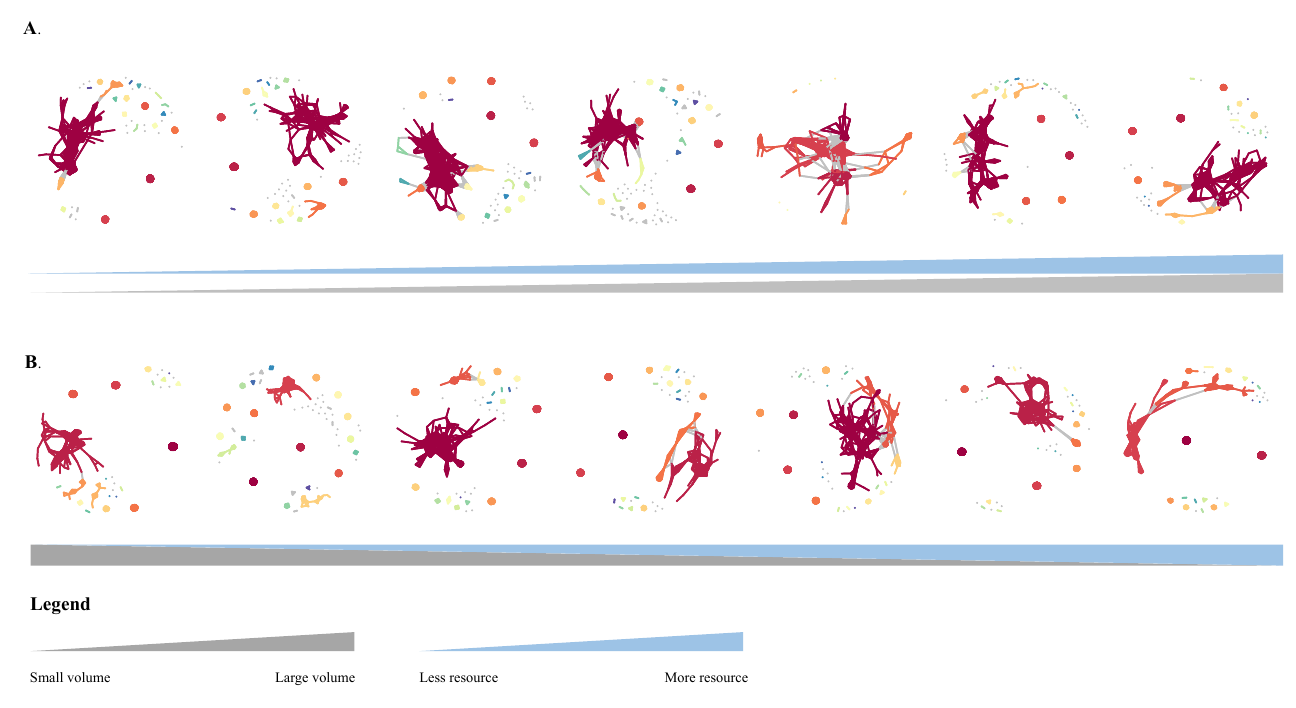
Figure 9. Microbial interactions network. ( A ) is the positive group, ( B ) is the negative group; grey triangular areas represent microcosm volume changes and blue triangular areas represent resource volume changes.